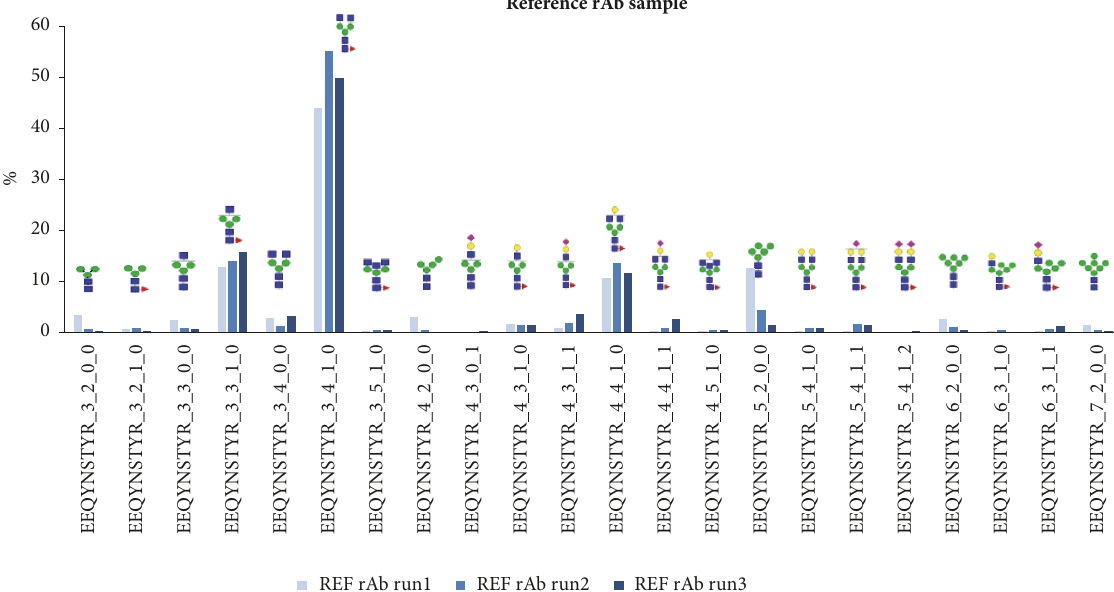
Figure 3: Triplicate analysis for glycosylation patterns of the reference rAb sample using LC-ESI-MS/MS. Each acquired mass dataset was normalized before comparative analysis. The sugar symbols: diamond (magenta) = sialic acid, circle (yellow) = galactose, square (blue) = GlcNAc, circle (green) = mannose, triangle (magenta) = fucose.